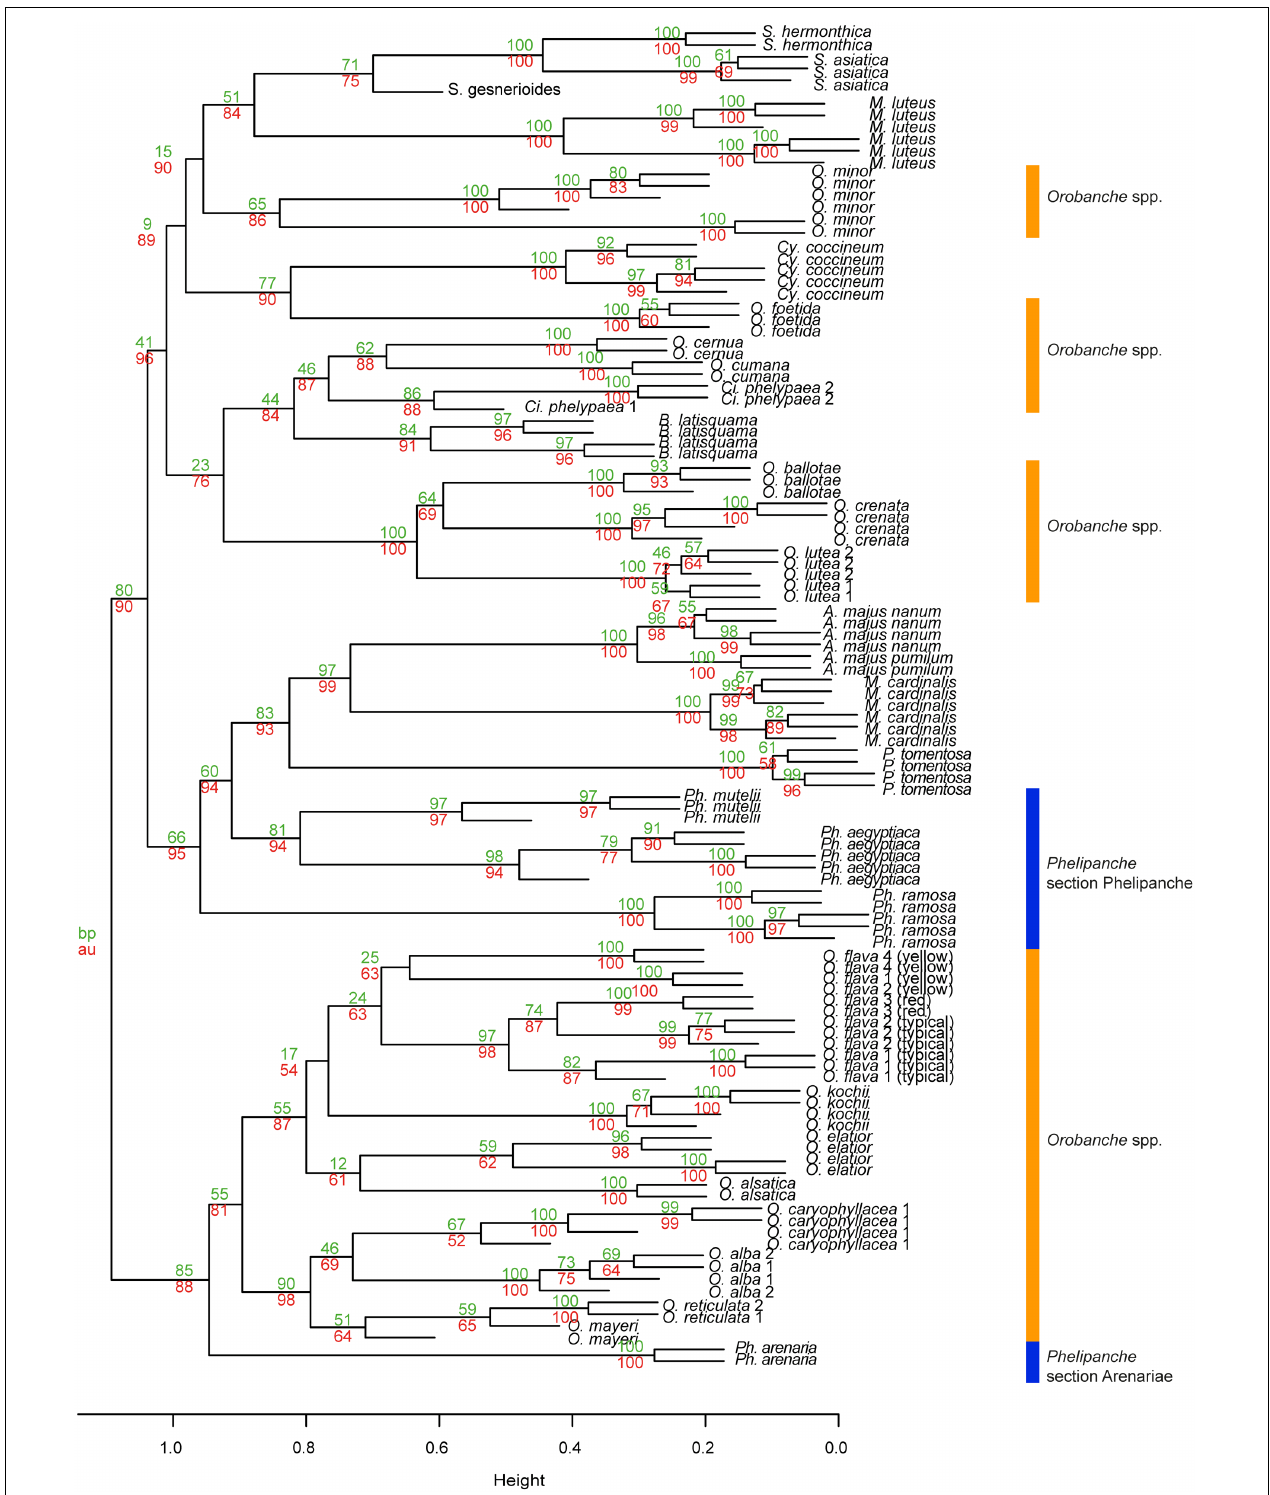
FIGURE 3 | Hierarchical clustering diagram of the flower VOC profiles of 32 species studied. HCA was performed with R and based on PCA of significantly different flower blends. Numbers at nodes are bootstrap probability P- value (BP, upper green numbers) and approximately unbiased P- values (AU, lower red numbers). The definition of the two genera of Orobanche is designated in orange (genus Orobanche ) and blue (genus Phelipanche ) bar; section Arenariae is also indicated (subsections within genus Orobanche are shown in Figure 6 ).